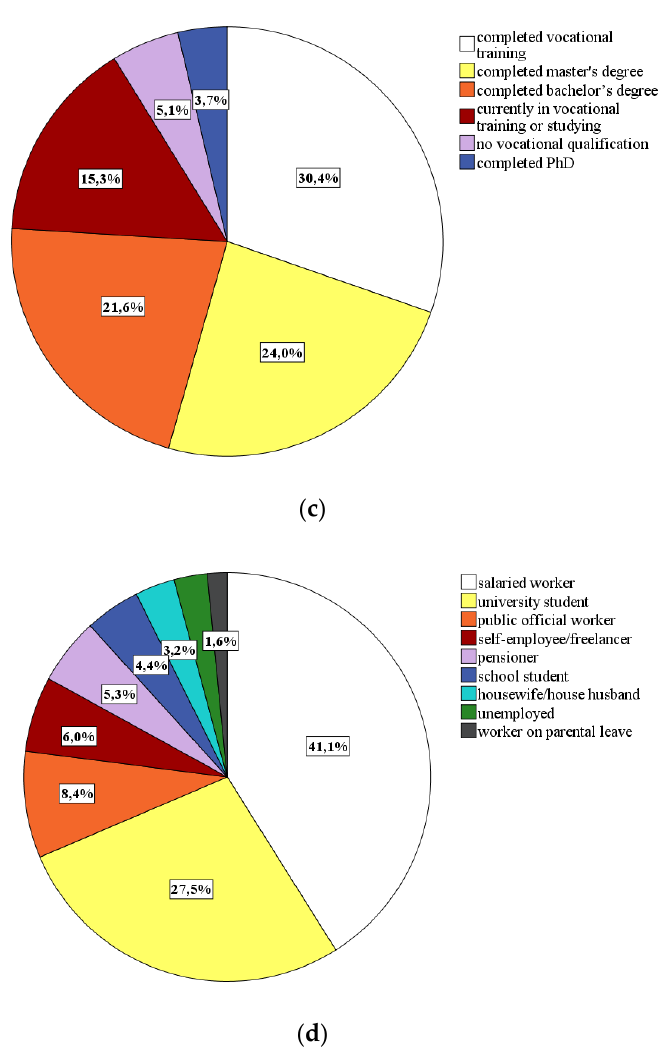
Figure 2. Sociodemographic sample characteristics ( N = 570): ( a ) subjects’ marital status; ( b ) subjects’ school education levels; ( c ) subjects’ vocational training levels; ( d ) subjects’ current professional status.